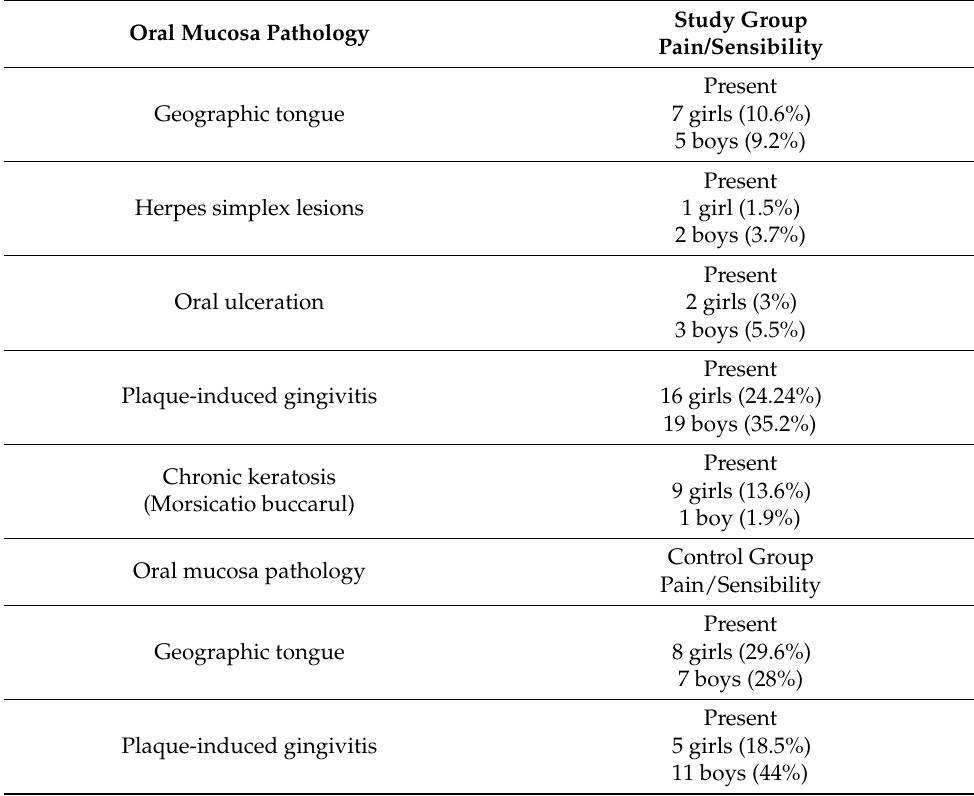
Table 5. Oral mucosa pathology pain or sensibility in patients representing the study and con- trol